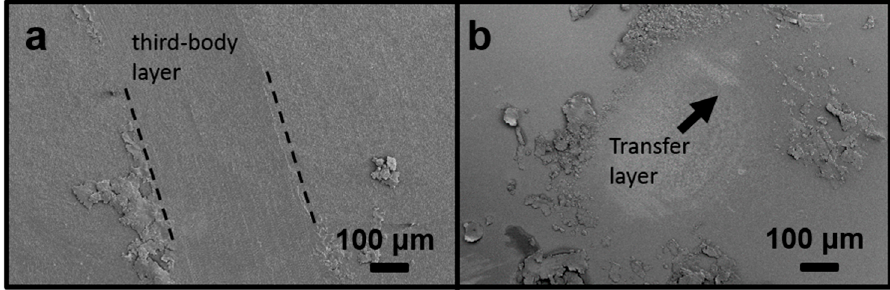
Figure 9. ( a ) Third-body film ( b ) transfer film on the steel ball.